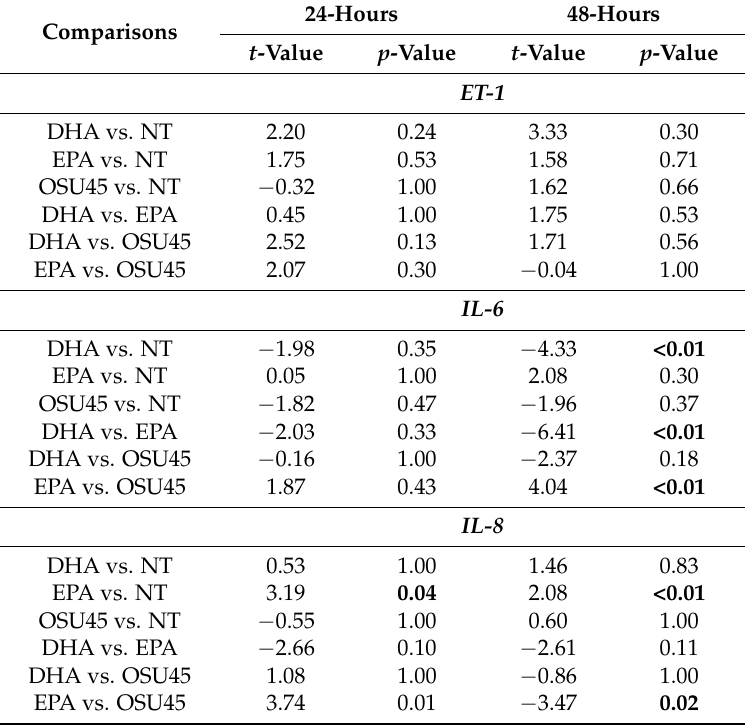
Table 1. Comparisons between ω -3 PUFA treatments and the no treatment control (NT) using the Bonferroni correction for multiple